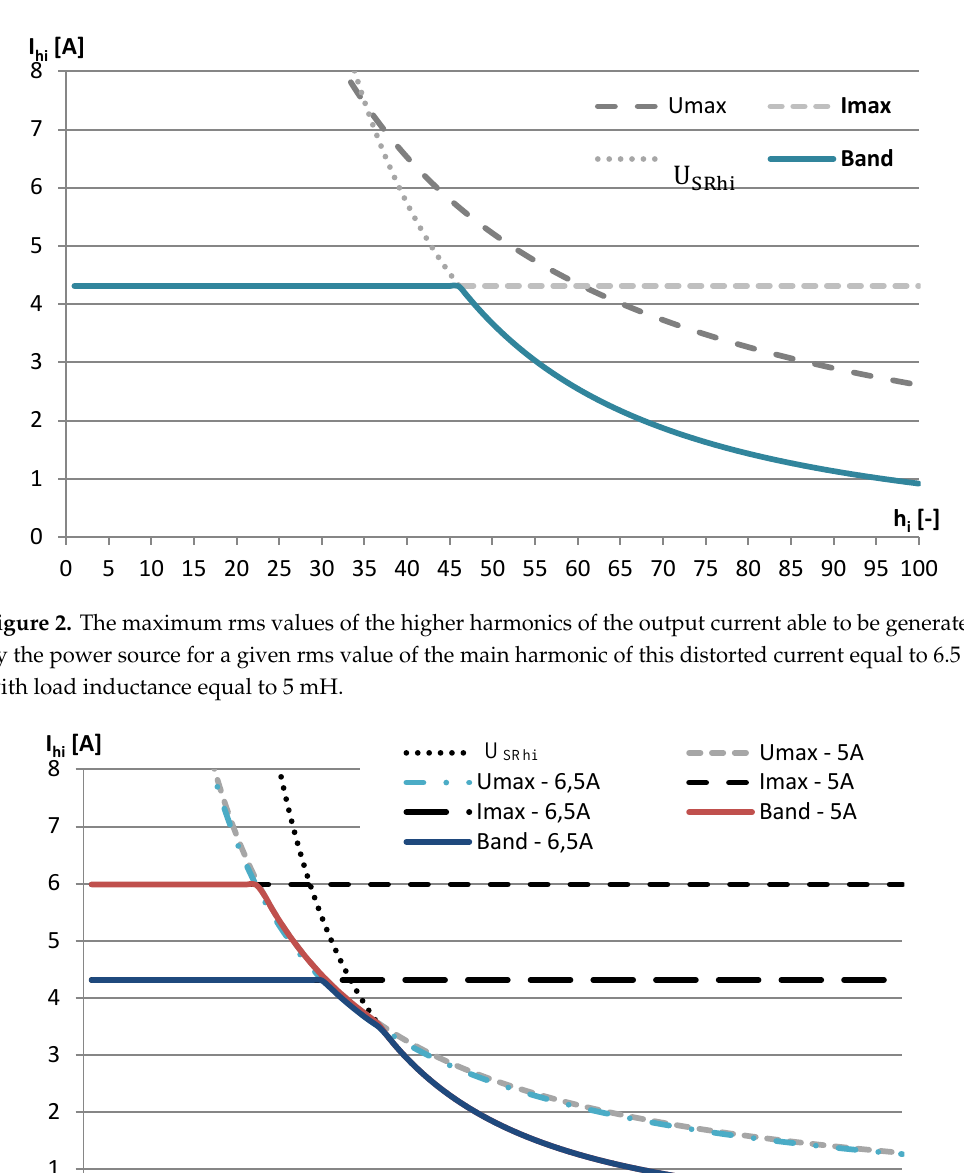
Figure 3. The maximum rms values of the higher harmonics of the output current able to be generated by the power source for a given rms value of the main harmonic of this distorted current equal to 6.5 A and 5 A with load inductance equal to 10 mH.